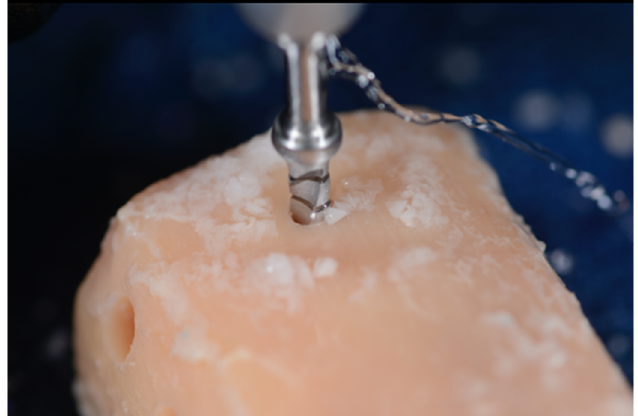
Figure 6. The initial temperature was recorded holding the K-Type thermocouple probe against the bony outer cortical layer (Step 1) [24].